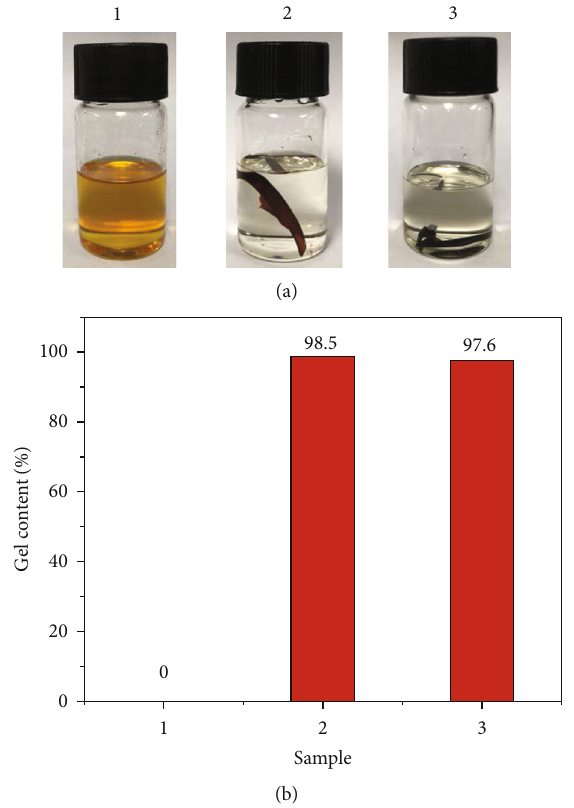
Figure 4: (a) Photographs and (b) gel content of membranes after the solubility test in NMP at 90 ° C for 12h. (1) PBI, (2) PAEK- cr - PBI, and (3) PAEK- cr